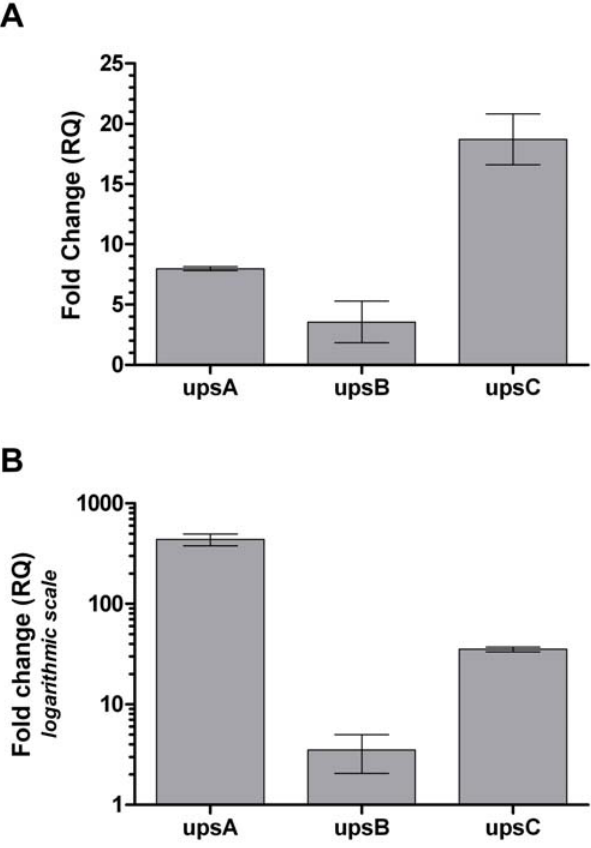
Figure 6. The effect of pfsir2 inactivation on var gene expression. A . Change of expression of ups subtypes in NAC exposed wild-type culture in relation to an unexposed culture. Synchronized ring stage parasites were exposed to 5 m M of NAC for 8 hours. B . Relative expression of ups subtypes in the pfsir2 knock-out line in relation to the wild-type line under normal culturing conditions. Note that y axis is in logarithmic scale. cDNA production and qPCR analysis were performed as described in the legend to Fig. 1.